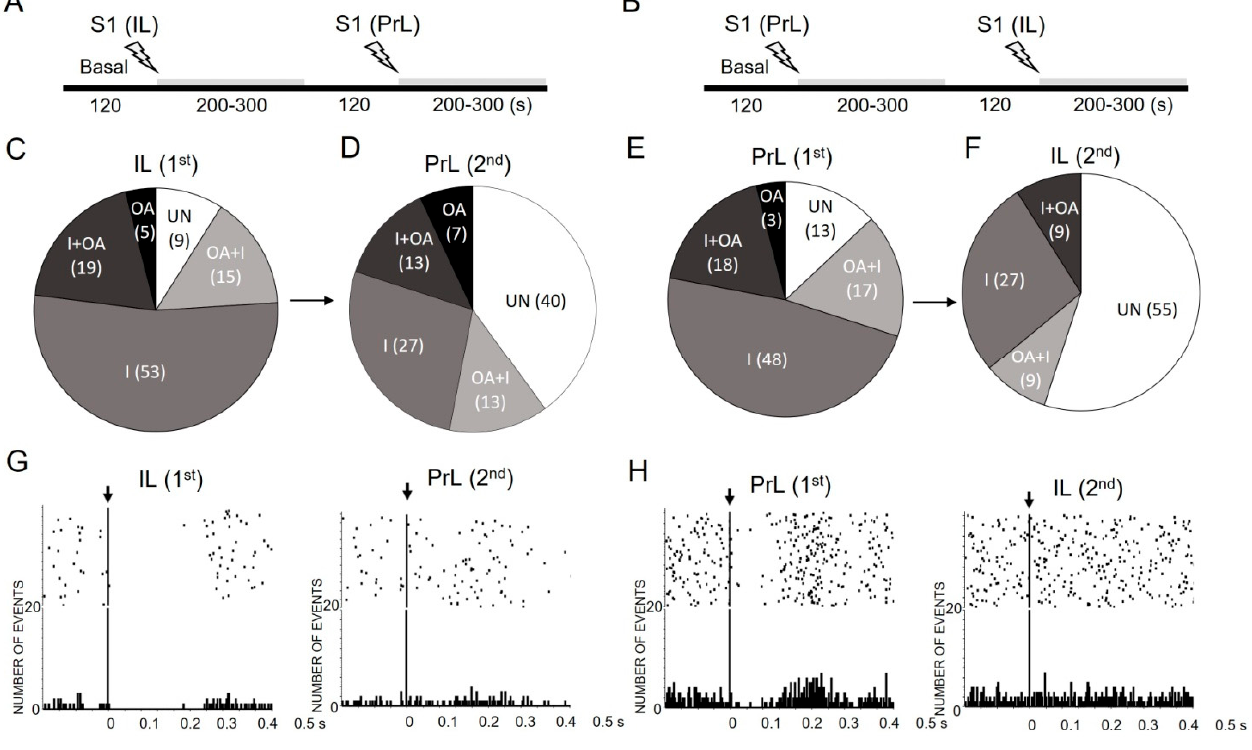
Figure 1. Effects of low-frequency electrical stimulation of infralimbic (IL) and prelimbic (PrL) cortices on 5-HT neuronal responses in dorsal raphe (DR). ( A , B ) Schematic representation of the procedures used to examine the responses of DR 5-HT neurons to IL → PrL ( A ) and PrL → IL ( B ) stimulation at a low frequency (S1; 0.9 Hz, 0.2 ms, 1.7 mA). Two different stimulation electrodes were placed in the IL and PrL subdivisions of the same rat (same hemisphere). After 120 s of stable recording (basal), one of the electrodes (IL or PrL) was stimulated, and the response evoked in an identified 5-HT neuron was recorded for 200–300 s. After a 120 s period, we examined the response of the same 5-HT neuron to the stimulation of the electrode placed in the other subdivision (PrL or IL) using exactly the same stimulation characteristics (0.9 Hz, 0.2 ms, 1.7 mA; 200–300 s recordings). ( C – F ) Pie charts showing the proportions (%) of the different response types evoked in DR 5-HT neurons by IL and PrL stimulation at a low frequency (S1, 0.9 Hz). Abbreviations: pure inhibitory response (I); pure orthodromic activation (OA); orthodromic activation followed by inhibition (OA + I); inhibition followed by orthodromic activation (I + OA); unaffected (UN). Figures ( C , D ) represent the responses of 5-HT neurons first to IL (1st) and then to PrL (2nd) stimulations, whereas figures ( E , F ) show the responses of 5-HT neurons first to PrL (1st) and then to IL (2nd) stimulations. Figures ( G , H ) show representative peristimulus—time histograms (PSTHs) for IL → PrL (( G ), pure inhibition → unaffected) and for PrL → IL (( H ), inhibition followed by activation → unaffected) driven stimulations. Note (1) the predominance of inhibitory (I) responses to both IL and PrL stimulation (53% vs. 48%, respectively) (pie charts ( C ) vs. ( E ), chi-square test n.s.), and that (2) the second stimulation resulted in a very large percentage of unresponsive neurons (40% to IL; 55 to PrL) (pie charts ( C ) vs. ( F ), chi-square test p < 0.0001; pie charts ( D ) vs. ( E ), chi-square test p < 0.0001; pie charts ( D ) vs. ( F ), chi-square test p <